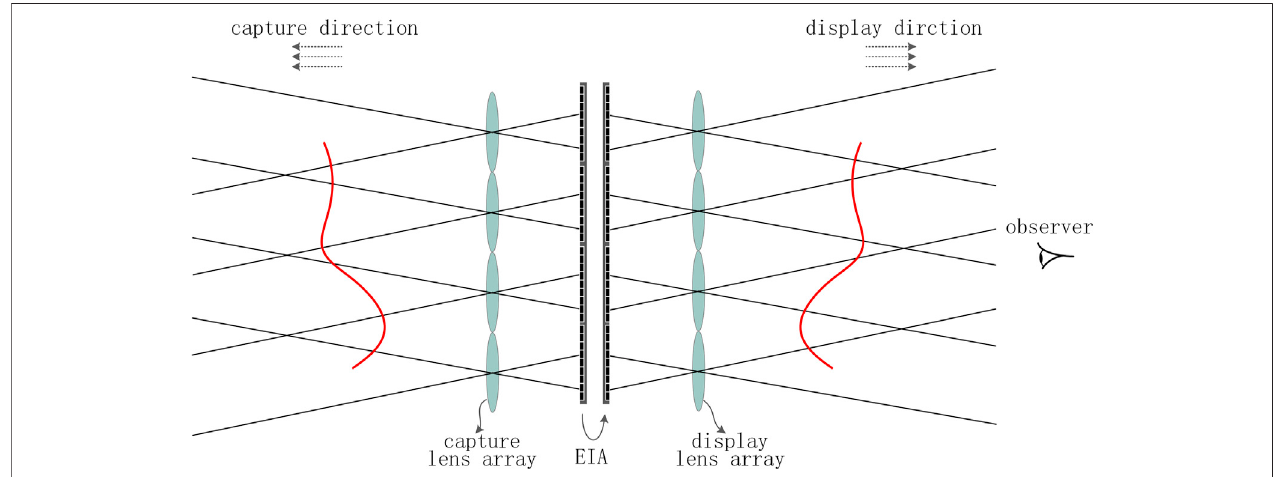
FIGURE 1 | Artifacts in integral